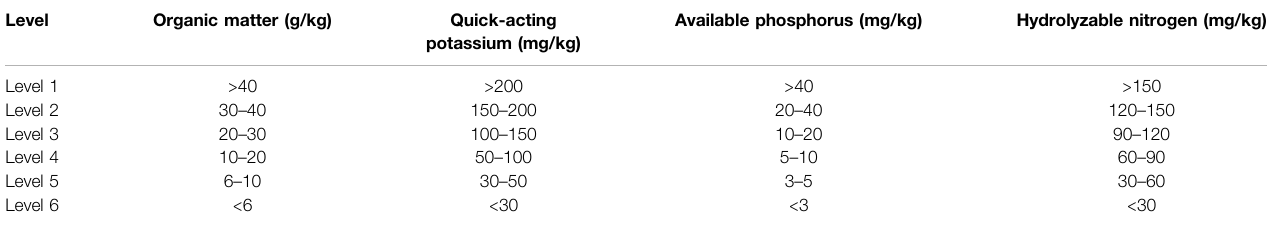
TABLE 4 | Nutrient classi fi cation standard of the second national nutrient census.